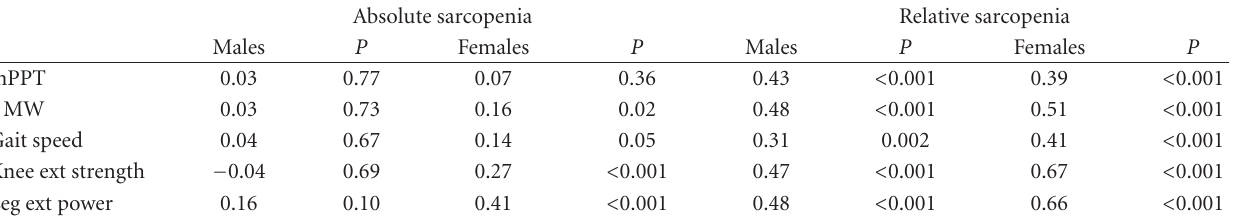
Table 2: Bivariate Correlation Results. Absolute (ASM/Ht 2 ) and relative (ASM/kg) sarcopenia and modified physical performance test (mPPT), six-minute walk (6MW), gait speed, normalized knee extension strength ( N /BMI), and normalized leg extensor power ( W /BMI).